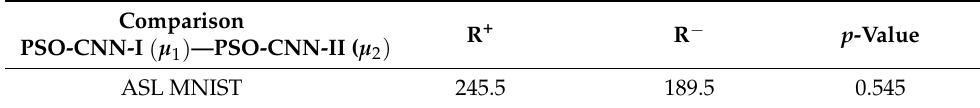
Table 18. Wilcoxon test results for the ASL MNIST.